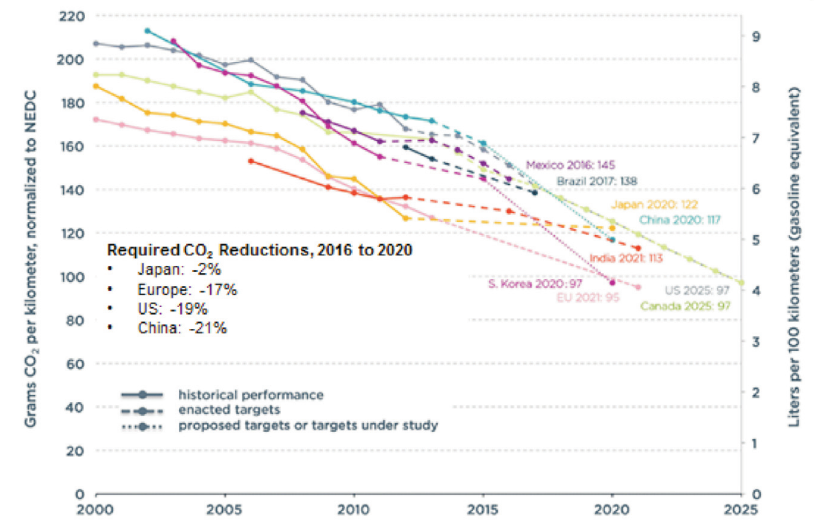
Fig. 2. Comparison of LD CO